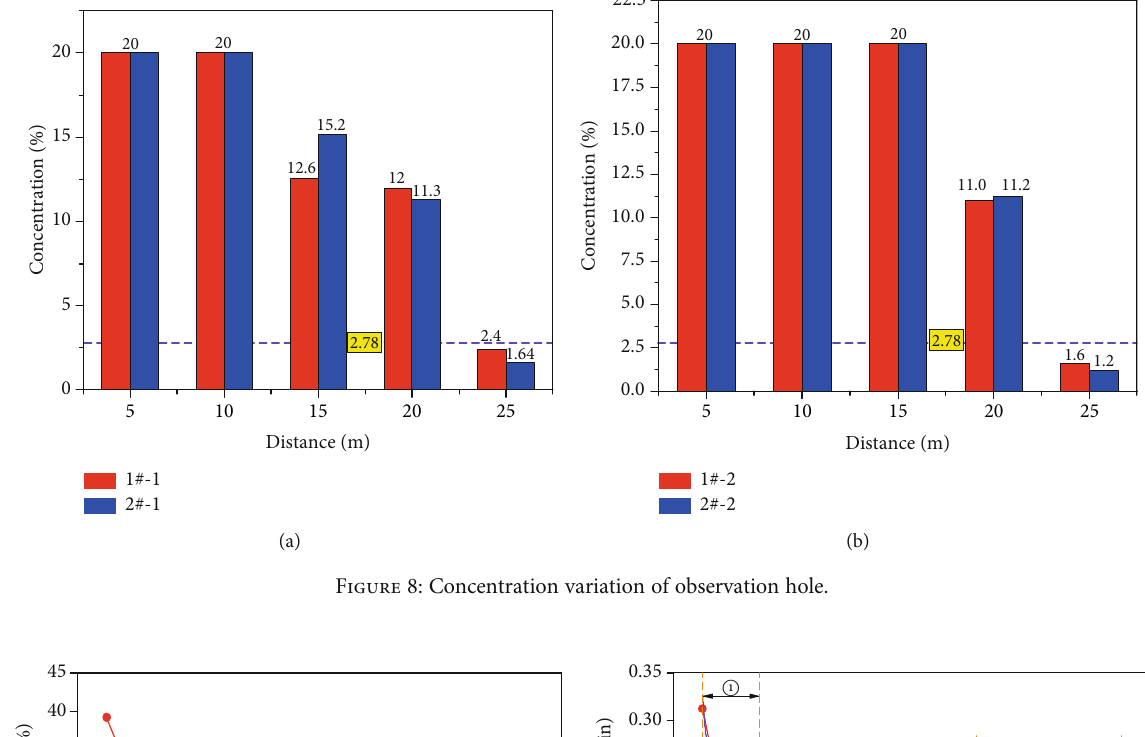
Figure 8: Concentration variation of observation hole.